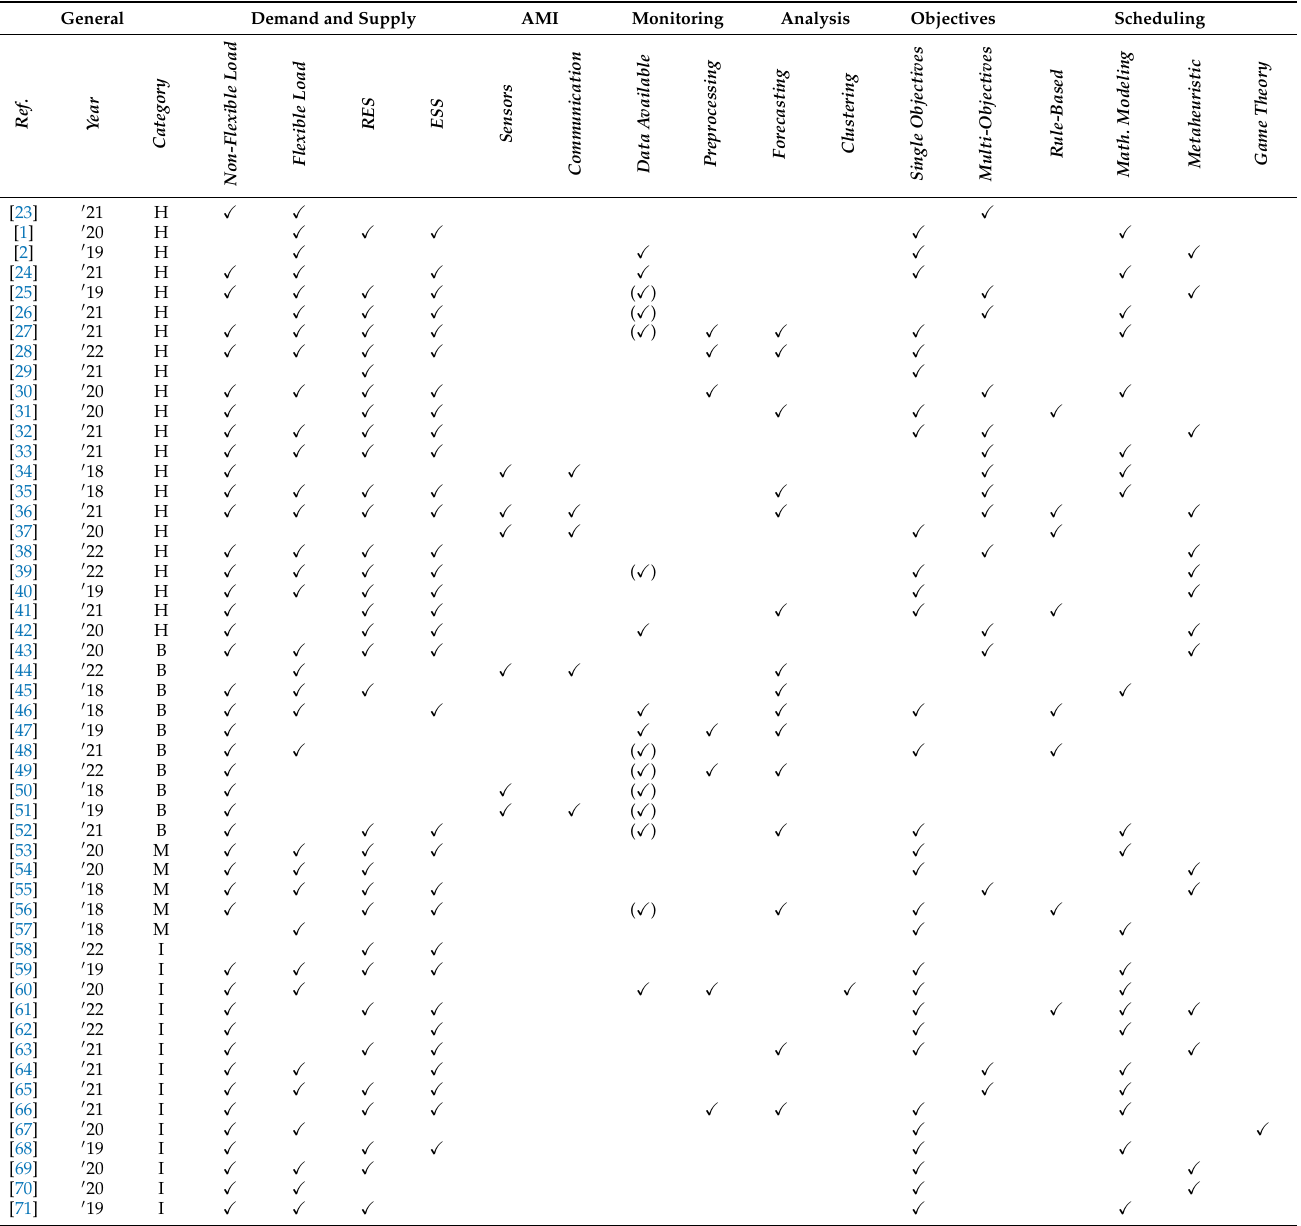
Table 2. Concept matrix in the literature of residential and industrial energy management systems. General Demand and Supply AMI Monitoring Analysis Objectives